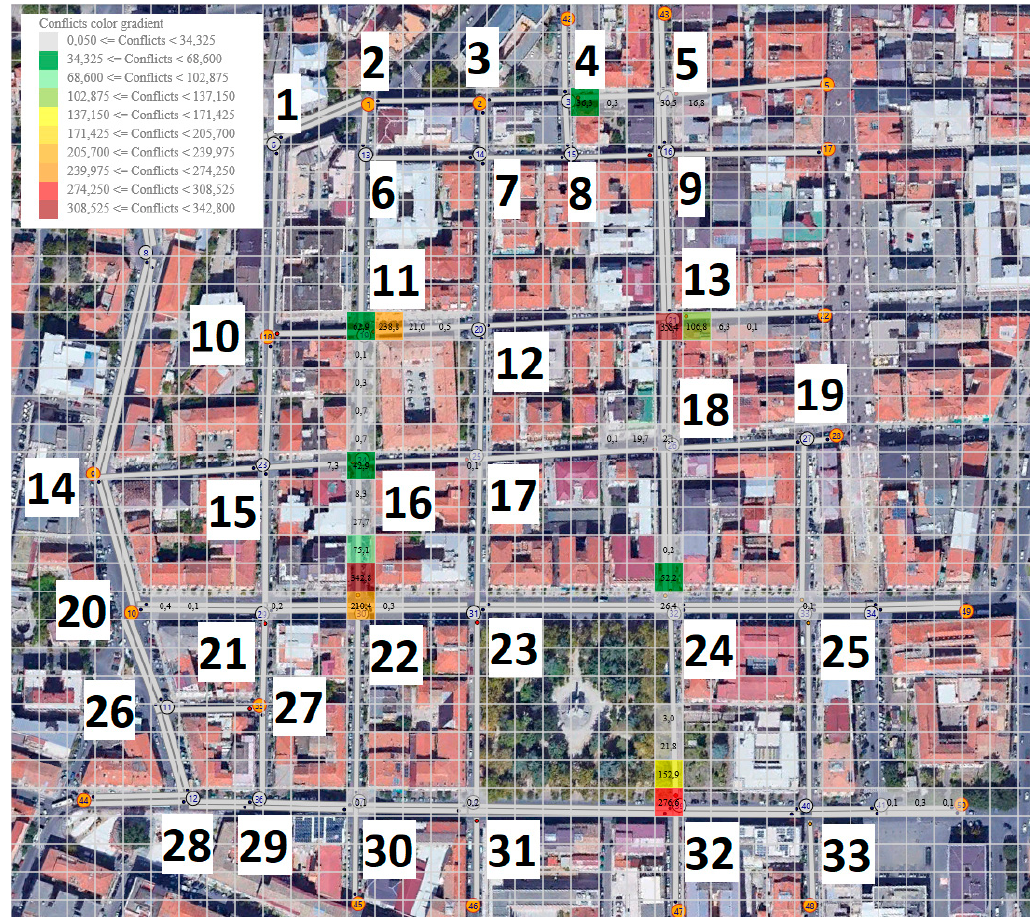
Figure 3. Simulated road network in TRITONE.